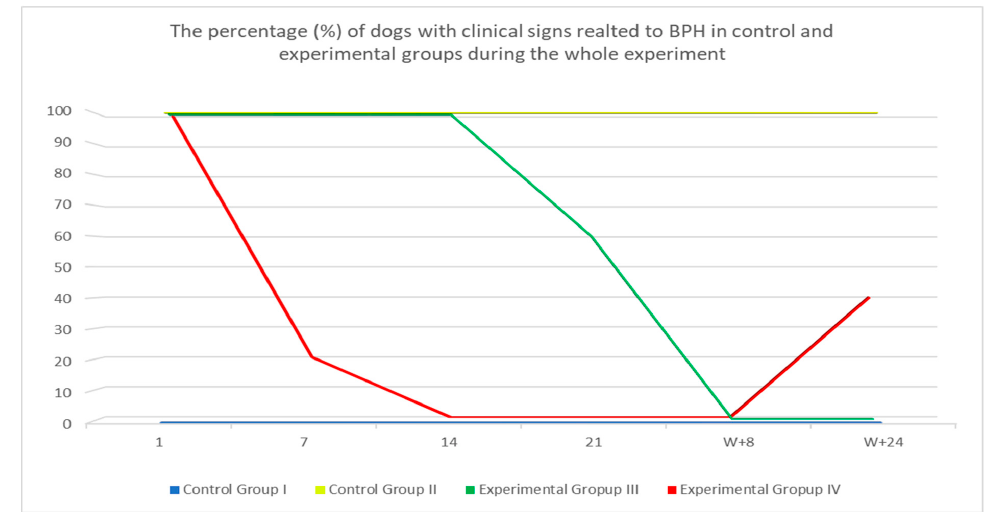
Figure 4. The percentage (%) of investigated dogs with clinical signs related to BPH Control Group I, II and Treated Groups III, IV during the whole observation